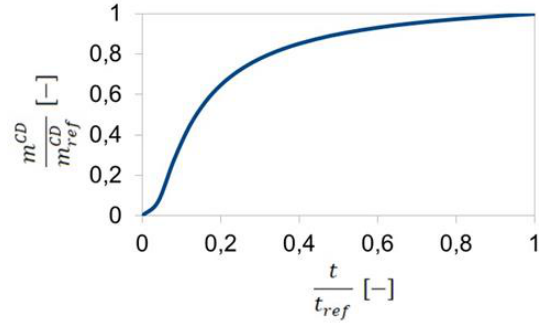
Fig. 5. The CD mass in the EGR valve m CD /m refCD vs. time t/t ref